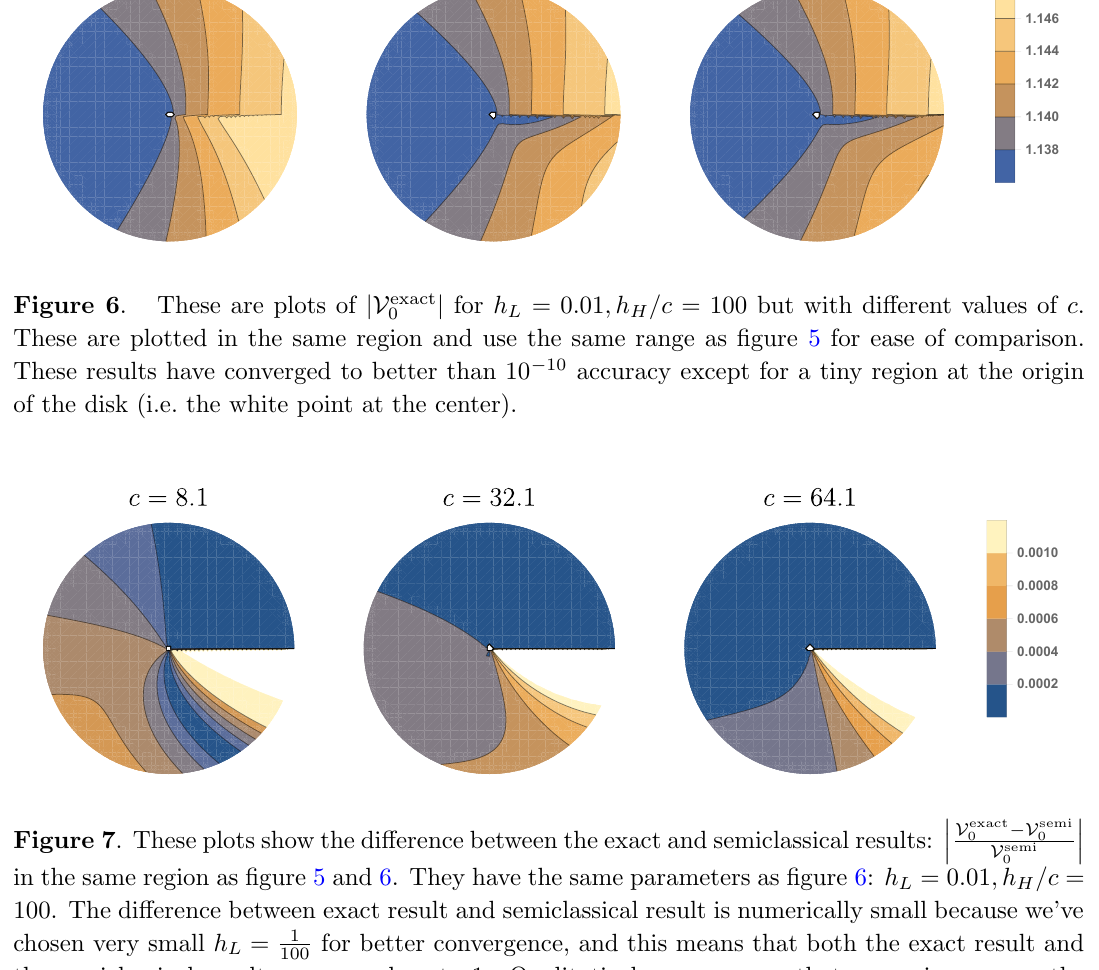
Figure 7 . These plots show the di(cid:11)erence between the exact and semiclassical results: in the same region as (cid:12)gure 5 and 6. They have the same parameters as (cid:12)gure 6: h L = 0 : 01 ; h H =c = 100. The di(cid:11)erence between exact result and semiclassical result is numerically small because we’ve chosen very small h L = 1 for better convergence, and this means that both the exact result and 100 the semiclassical result are very close to 1. Qualitatively, we can see that as we increase c , the agreement between the exact result and the semiclassical result improves. The exact results have converged to better than 10 (cid:0) 10